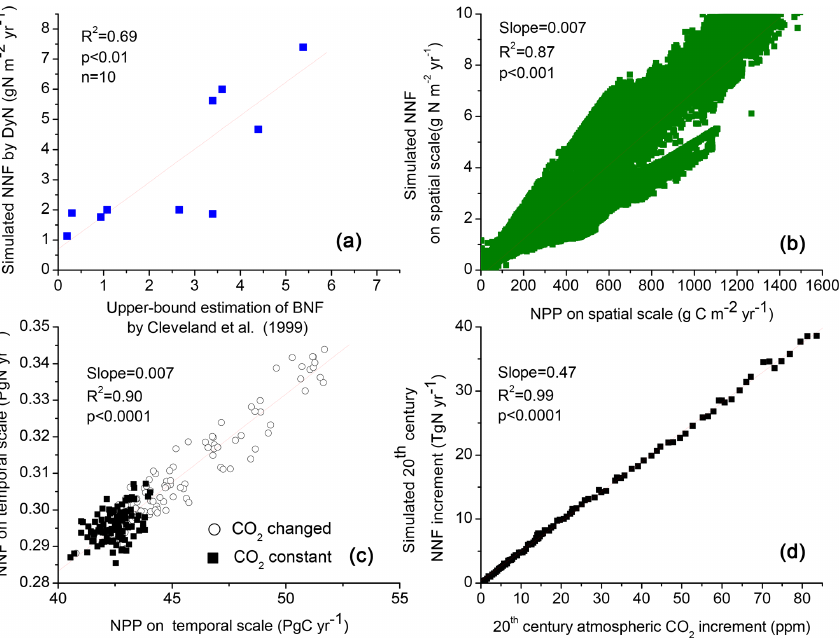
Figure 4. Modelled demand for newly fixed N, with e = 0 . 175. (a) Comparison of biome-average estimates with upper bound values from Cleveland et al. (1999). (b) Spatial relationship of NNF with NPP. (c) Temporal relationship of NNF with NPP during the 20th century. (d) Relationship of increased in global NNF to atmospheric CO 2